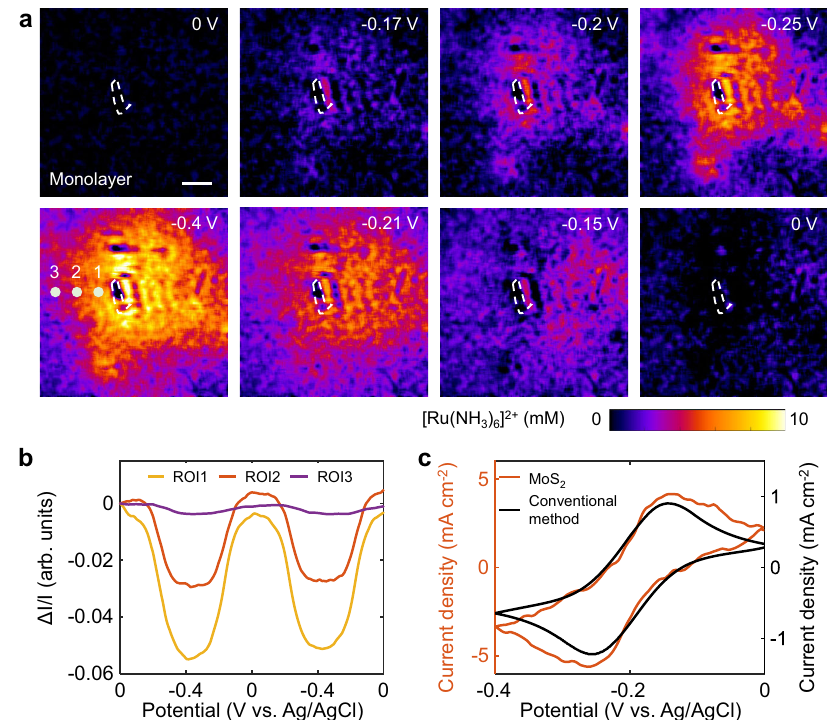
Fig.3|ImagesoftheelectrochemicalreactiononmonolayerMoS 2 .a Snapshots ofplasmonicimagesofmonolayerMoS 2 atdifferentpotentials,showingthespatial distribution of the concentration of [Ru(NH 3 ) 6 ] 2+ ions. The electrolyte was 0.25M phosphatebuffercontaining 10mM[Ru(NH 3 ) 6 ]Cl 3 .Thescalebarrepresents15 μ m. b Plasmonic intensity curves of three ROIs adjacent to monolayer MoS 2 vs.